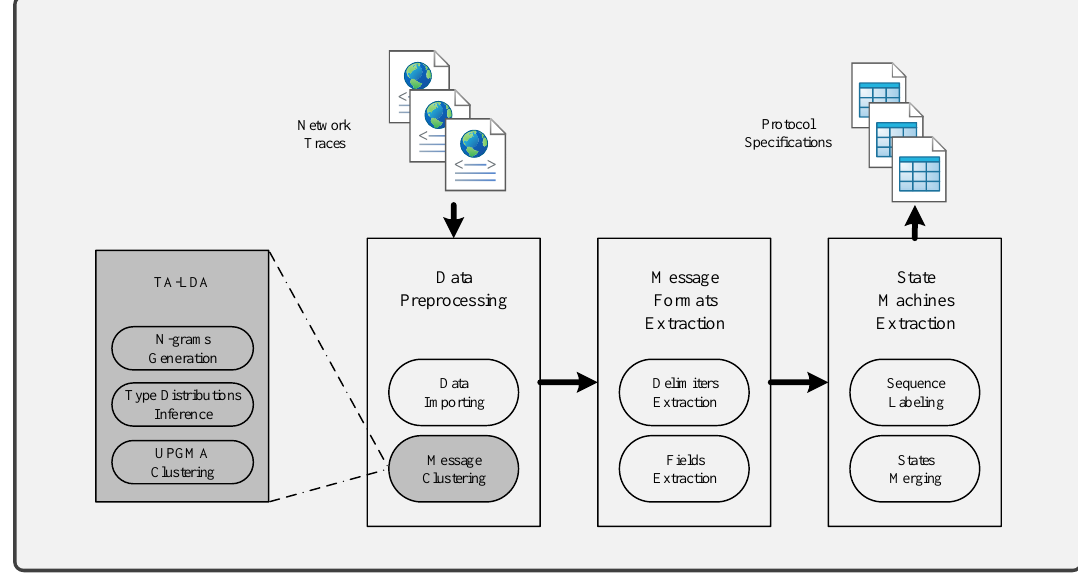
Figure 2. Overview of